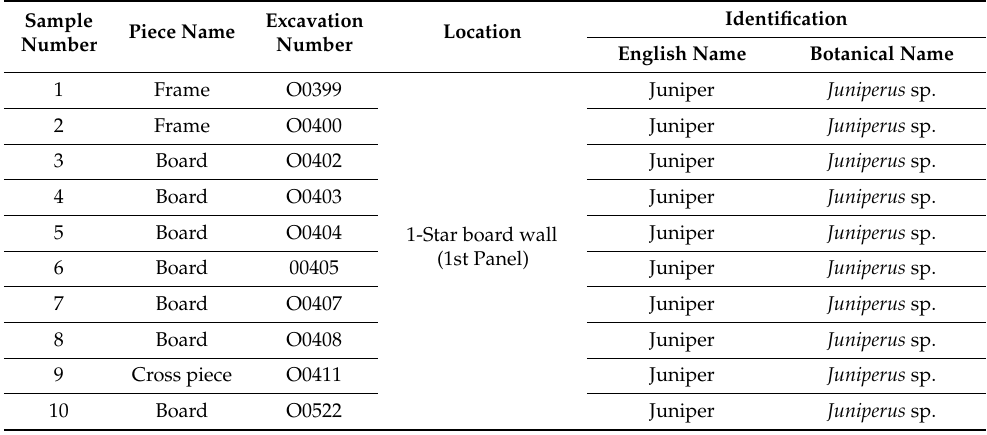
Figure 4. Rendering of the wood species used on the forecastle as numbered in Table 3. Table 1. Sample number, piece name, excavation number, location, and species identification for the deckhouse